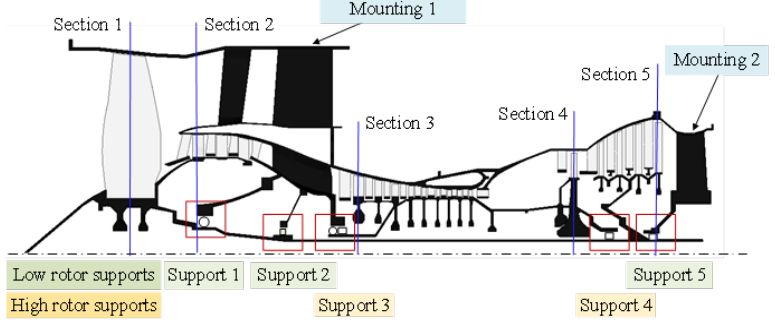
Figure 5. Supports and mountings of the specified engine. Table 1. Stiffness values of